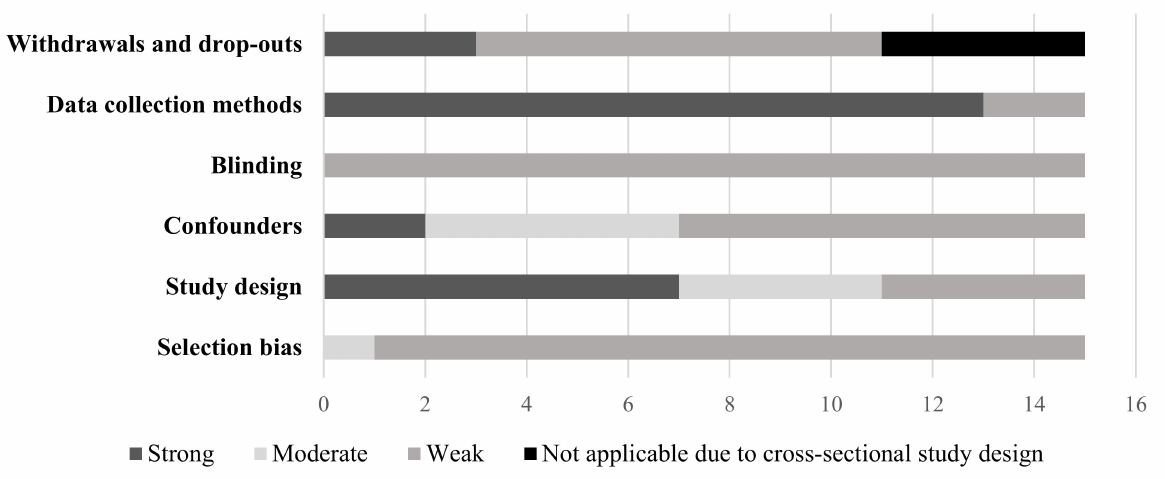
Figure 3. Quality of quantitative studies by assessment item—Cognitive Development.